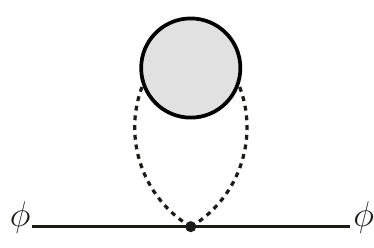
Figure 5 . General structure of plant diagrams which contribute to the e(cid:11)ective Hamiltonian in (cid:30) 4 theory. These higher-point correlation functions correspond to Feynman diagrams which contribute to the one-particle mass in equal-time quantization but vanish in lightcone quantization. By including these terms in H e(cid:11) , our prescription eliminates the naive discrepancy between the two quantization